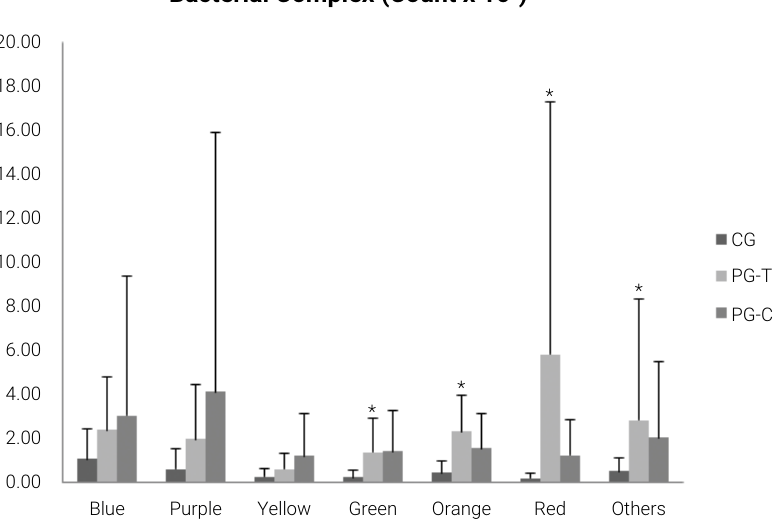
Figure 4. Levels (mean and SD) of bacterial complexes in different groups (Healthy – Control, CG; Periodontitis – Test, PG-T and Periodontitis – Control, PG-C). Statistically significant differences among groups were evaluated by Kruskal-Wallis followed by Mann-Whitney Test